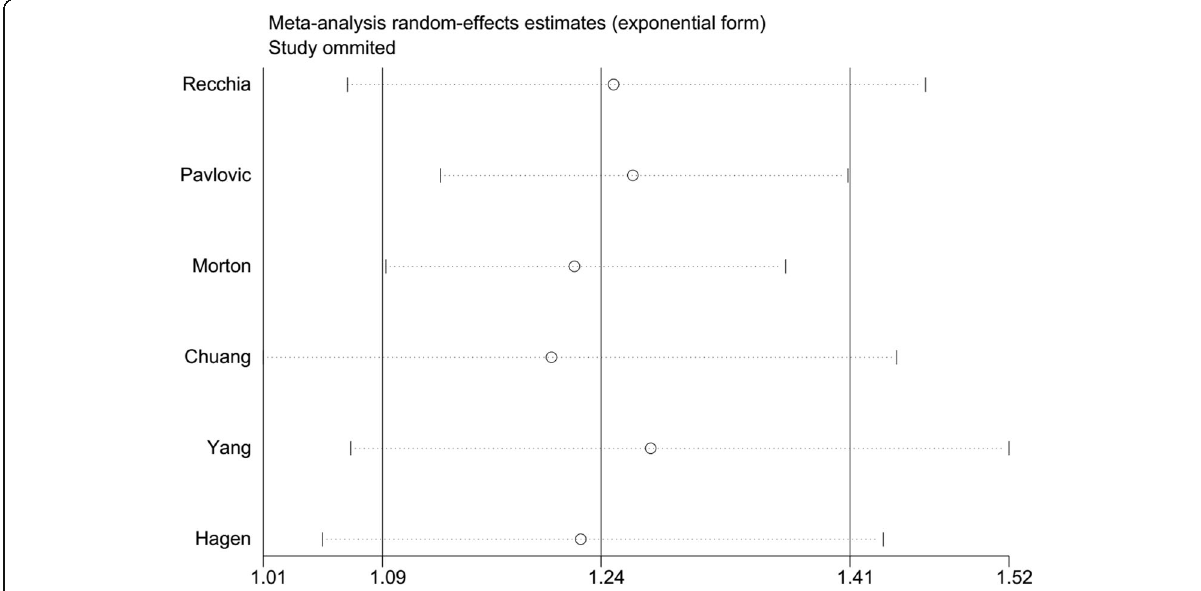
Fig. 3 Plot of sensitivity analysis by excluding one study each time and the pooling estimate for the rest of the